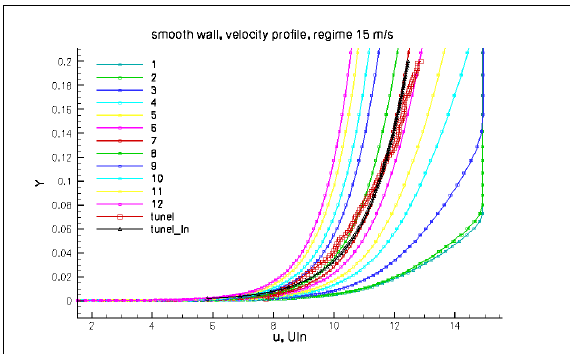
Fig. 2. Initial condition 1570, velocty profile. CFD simu- lation, regime u ∞ = 15m.s − 1 . Horizontal velocity profiles of the flow above the flat plate at given distances from the start of the plate (4.6,5,10,20,30,50,70,100,200,300,500,700). Data measured during the VZLU experiment are shown by the red boxes, black triangles approximate this profile by logarithmic curve. The chosen cut at 70m is close to this experimental simu-